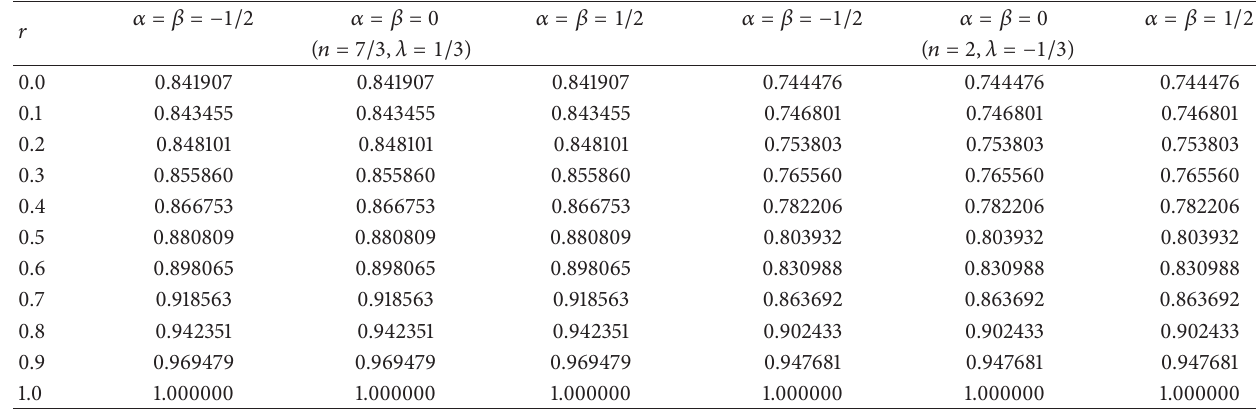
Table 2: Approximate solutions for 𝑁 = 24 .